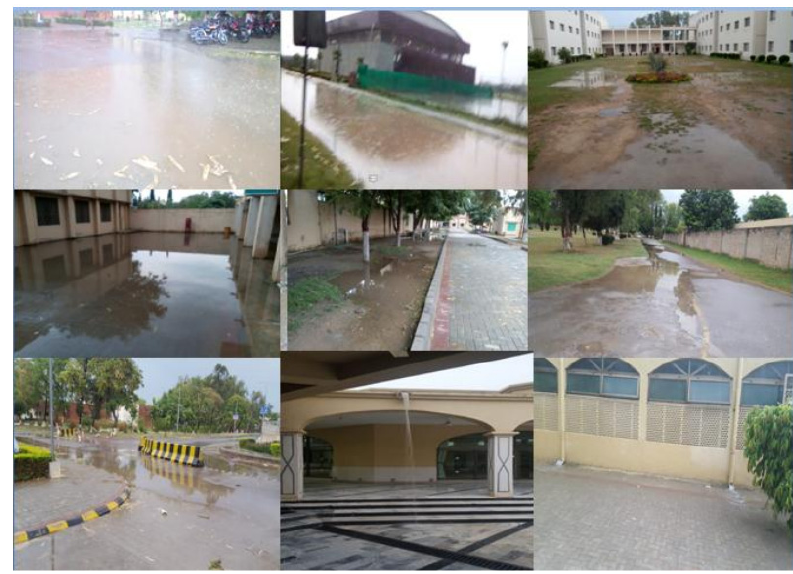
Figure 4. Water accumulation points observed during and after the rainfall events.